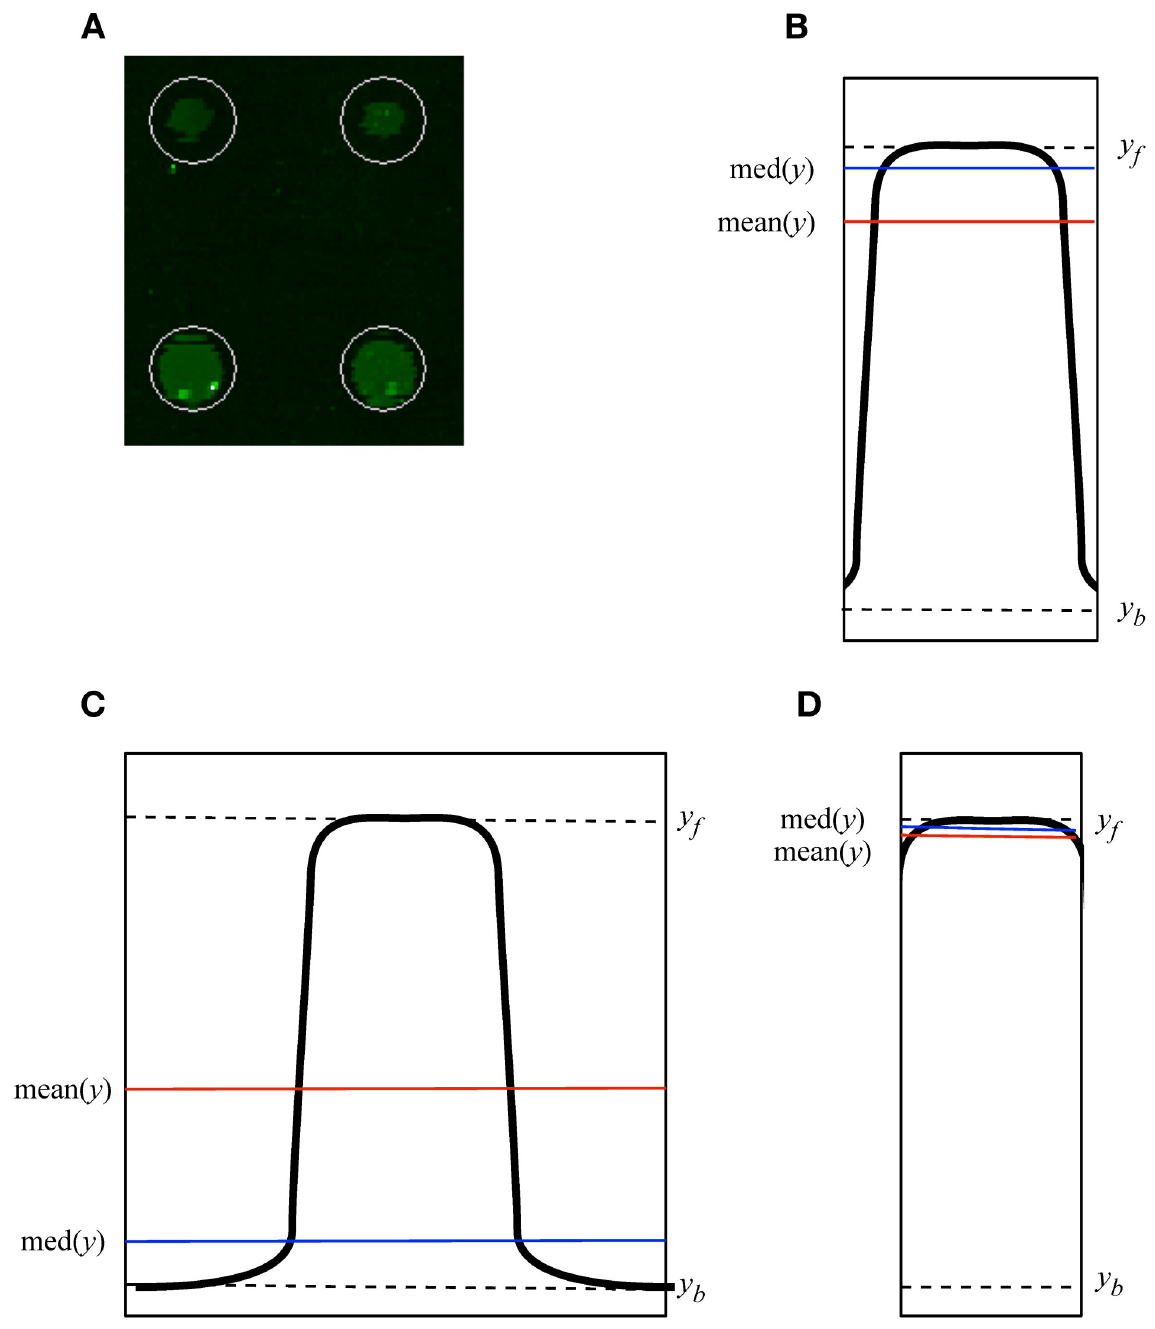
Fig 1. Over-estimation of spot size introduces error in estimation of mean and median spot intensity. A. The automated spot finding provided by the scanner software defaults to using a feature size (shown by the white circle) that captures the entire area of all spots, even the largest spots on the physical array. B. With an accurate feature size values of mean( y ) and med( y ) give a true representation of the spot. The vertical edges of the rectangle show the boundary between actual foreground and background pixels constituting the spot. C. Overestimated feature size, showing the resultant reduced mean (mean( y )) and further reduced median (med( y )). The mean estimated foreground intensity is lowered from the true foreground intensity ( y f ), towards the true background intensity ( y b ). D. Under-estimating feature size results in increased mean and median, though they are in the correct relationship and are closer to their true values than in panel C. This figure represents a simplification as the rendering in 2 dimensions does not show that the number of pixels increases linearly with the area of a circle, which itself increases as the square of the